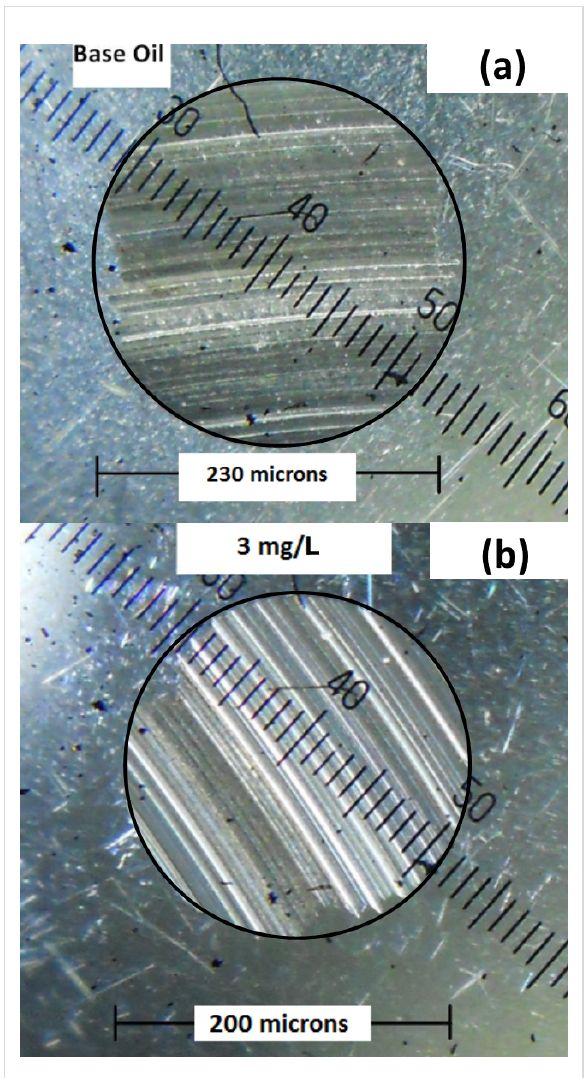
Figure 7: Wear scar diameter (WSD) of stainless steel balls lubricated with (a) base oil and (b) N-rGO nanolubricant (3 mg/L).